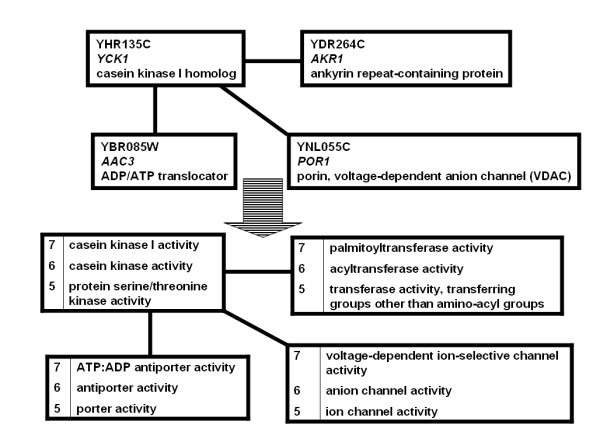
Annotation of GO terms at different depths on the constituents of a typical #4–0 motif. A typical #4–0 motif. For each protein, the open reading frame name, the gene name and the full name are provided. GO terms for each node are provided at three GO depths (five, six and seven). All nodes in the PPI network are labeled with GO terms for the discovery of the motif mode.